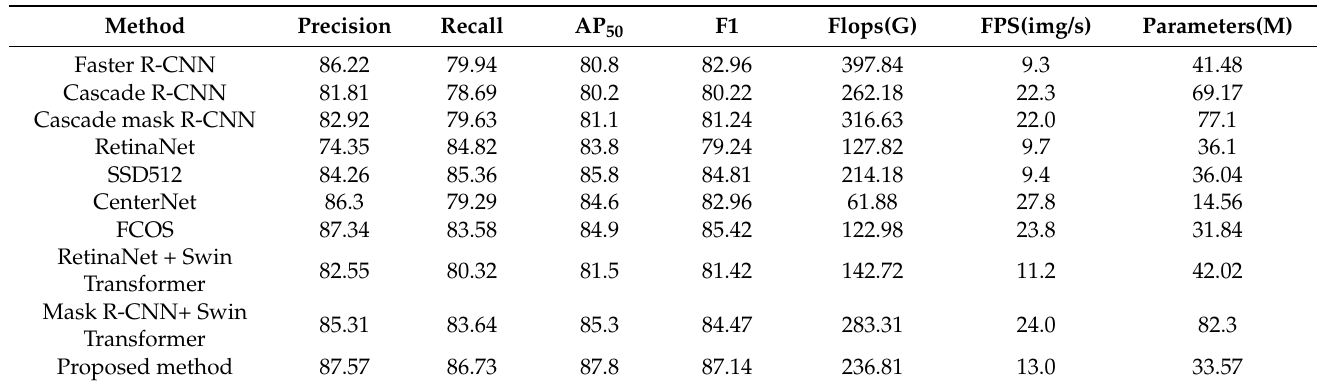
Table 4. Comparison with current object detection methods on the HRSID dataset.